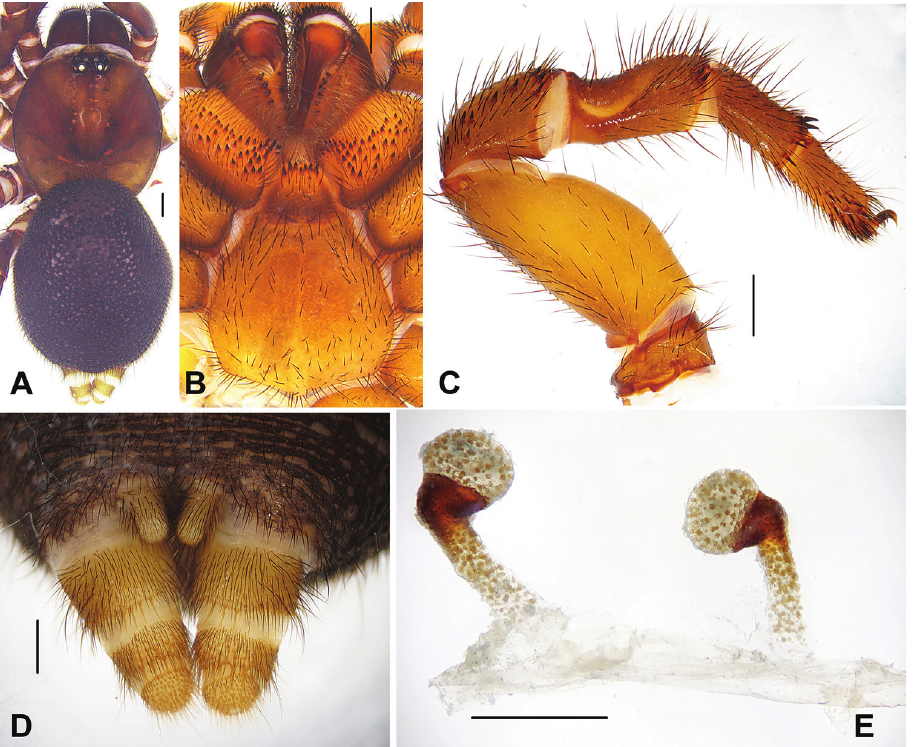
Figure 4. A General somatic morphology of Conothele yundingensis Xu, Xu & Li, sp. n. (female, XUC- 2014-001+) B chelicerae, labium, coxae of palp and sternum, ventral view C left leg III, prolateral view D spinnerets, ventral view E female genitalia, ventral view. Scale bars: A–D 1 mm, E 0.5